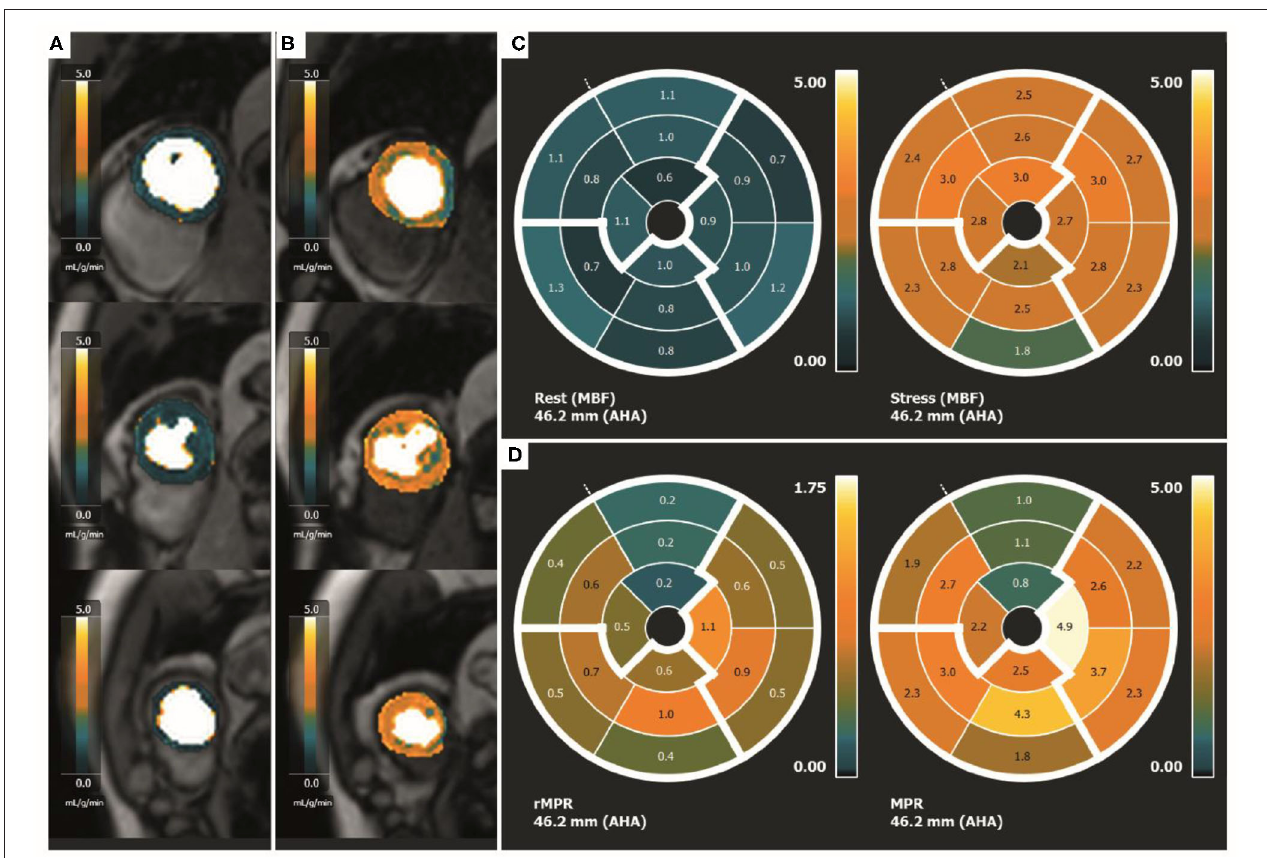
FIGURE 5 | Quantitative perfusion CMR. Quantitative perfusion CMR. (A) Rest MBF on SAX of the basal, mid-LV and apical slice, (B) Stress MBF on SAX of the basal, mid-LV and apical slice, (C) Polar maps demonstrating rest and stress MBF in each segment, (D) Polar maps of rMPR and MPRI in each segment. CMR, cardiac magnetic resonance; MBF, myocardial blood flow; SAX, short-axis images; LV, left ventricle; rMPR, relative myocardial perfusion reserve; MPRI, myocardial perfusion reserve